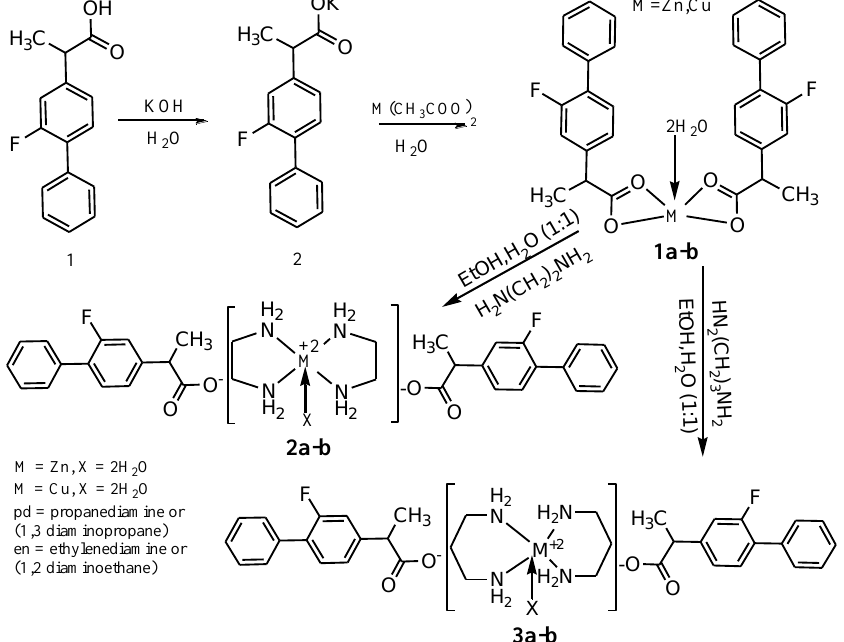
Figure 1. Scheme for the synthesis of bis (1,2-diaminoethan and 1,3-diaminoprpane) metal flurbiprofen complexes. (Flurbiprofen (C 15 H 12 FO 2 ) = L, 1,2-diaminoethane (C 2 H 8 N 2 ) = L1, 1,3-diaminpropane (C 3 H 10 N 2 ) = L2.).